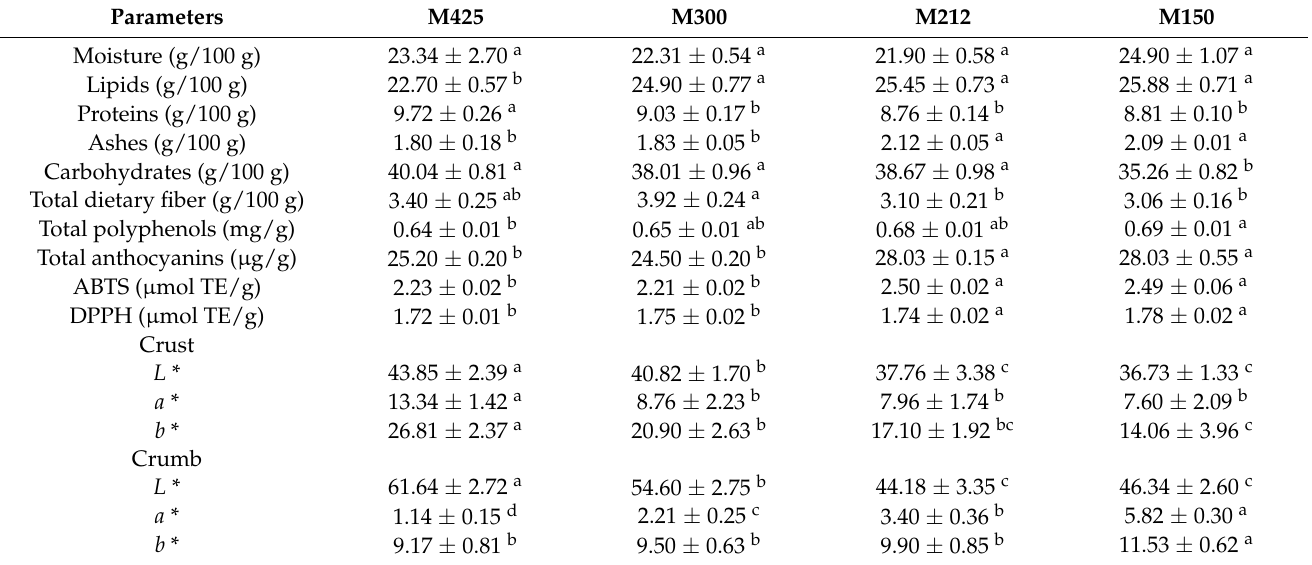
Table 3. Mean values, standard deviation and results of statistical analysis (one-way ANOVA followed by Tukey’s HSD test for multiple comparison) of proximate composition, polyphenol and anthocyanin total contents, antioxidant activity and crust and crumb colorimetric parameters (lightness, L *; redness, a *; yellowness, b *) of the different examined muffins.